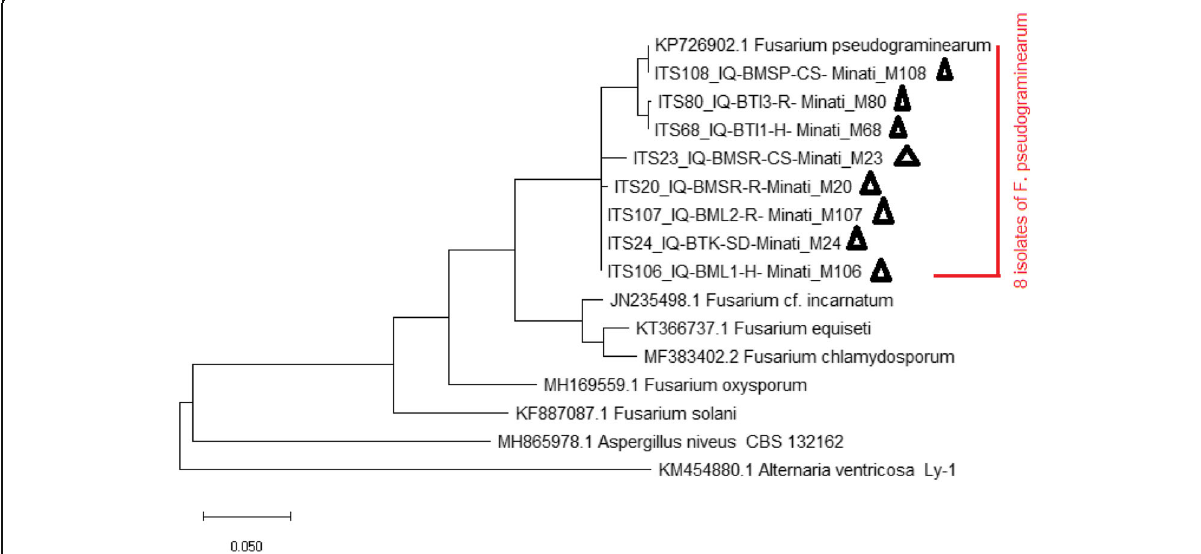
Fig. 10 Phylogenetic tree generated with the ITS-rDNA sequences of the Fusarium pseudograminearum (8), as inferred from the maximum likelihood (ML) analyses (determined by black triangles) and related species retrieved from GenBank. ITS sequences of Aspergillus niveus (MH865978) and Alternaria ventricosa (KM454880) were used as the out-group species